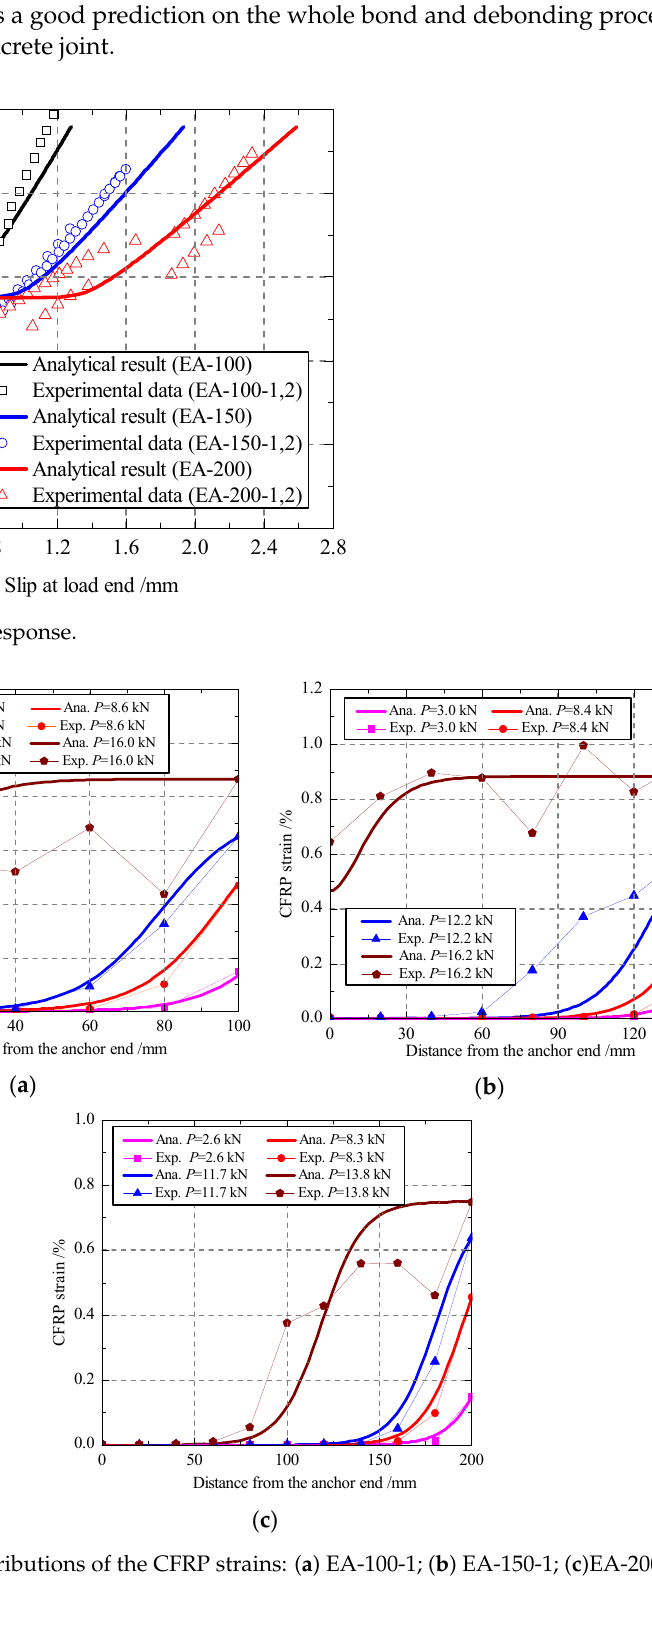
Figure 10. Load-slip response.